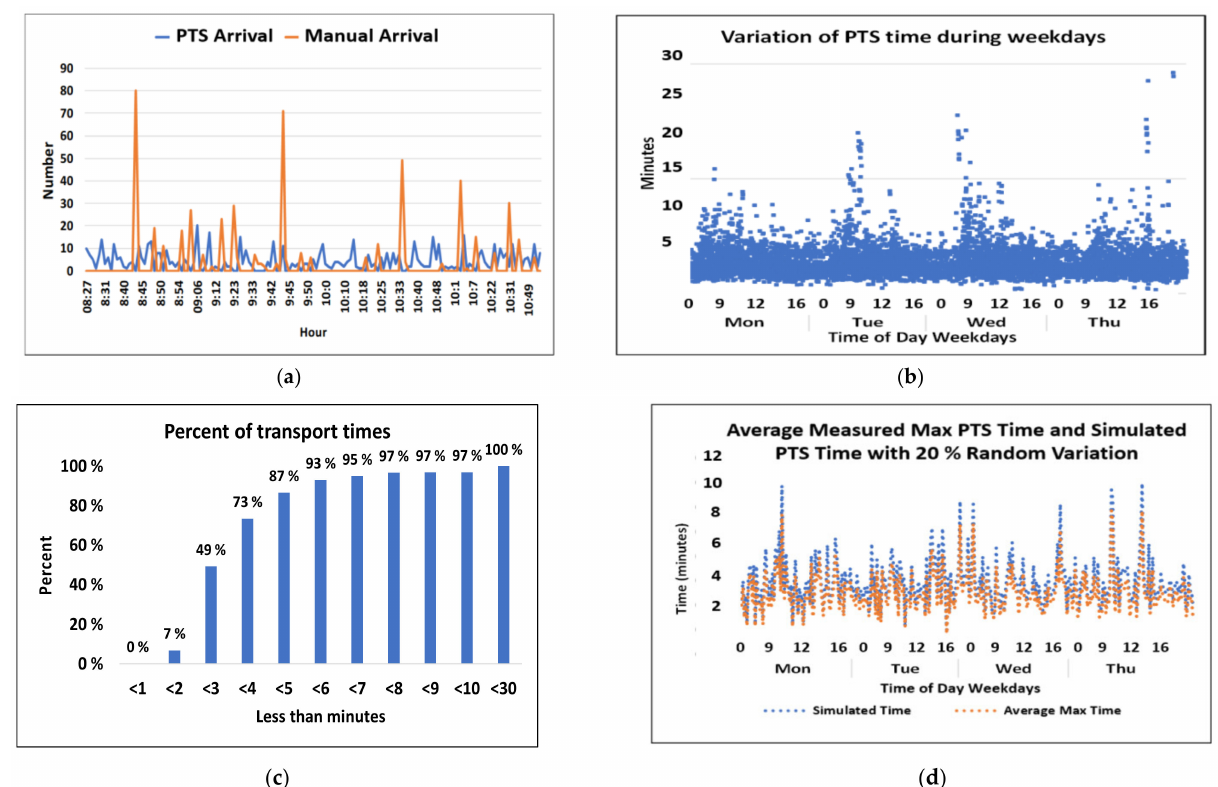
Figure 9. ( a ) Arrival rate measured at the drone loading site; ( b ) Measured transport time for an individual PTS; ( c ) Percent- age of PTS times within time frames variation; ( d ) Simulated maximum PTS time allowing 20% random.